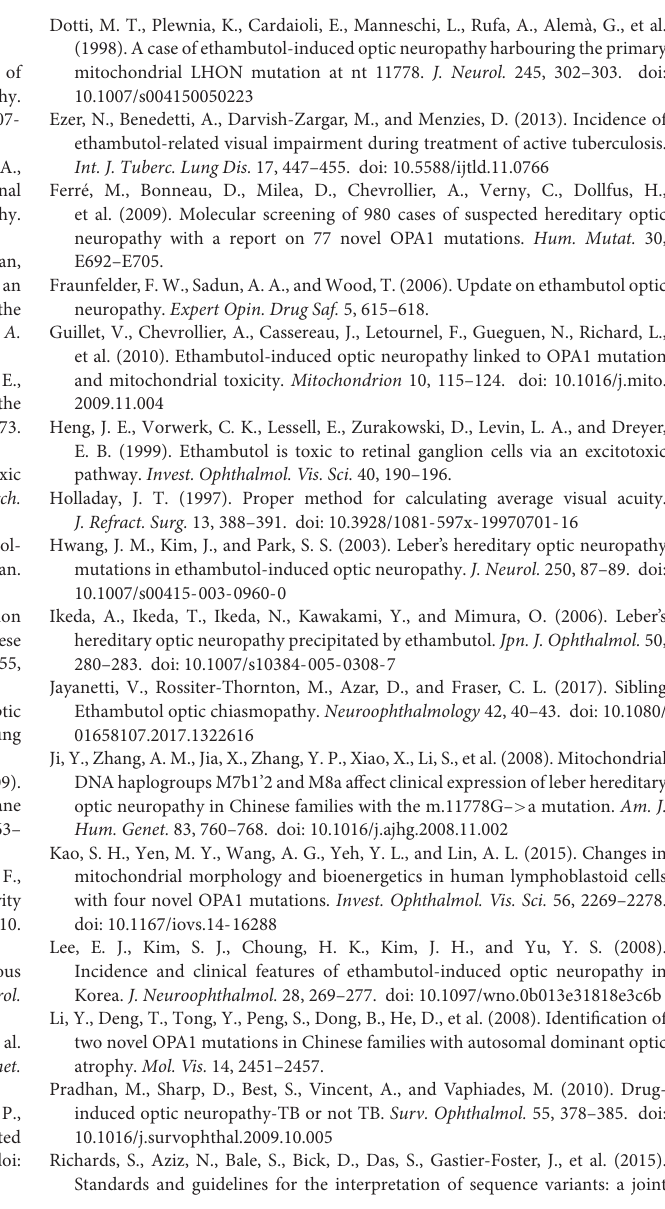
Supplementary Figure 1 | Sanger sequencing electropherograms for 17 identified OPA1 mutations in the study. Supplementary Figure 2 | Family pedigrees for seven patients with family history of optic